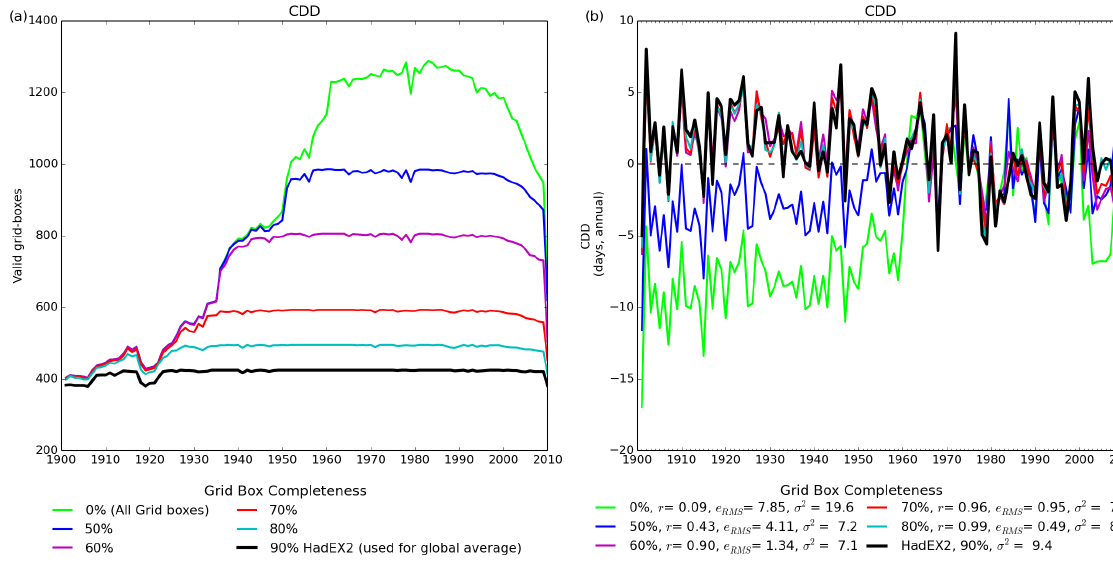
Figure 2. (a) Numbers of grid boxes covered given different completeness requirements, for CDD (consecutive dry days). (b) The time series for global average of TX90p of HadEX2 and different completeness requirements. For further details see Fig. 1.